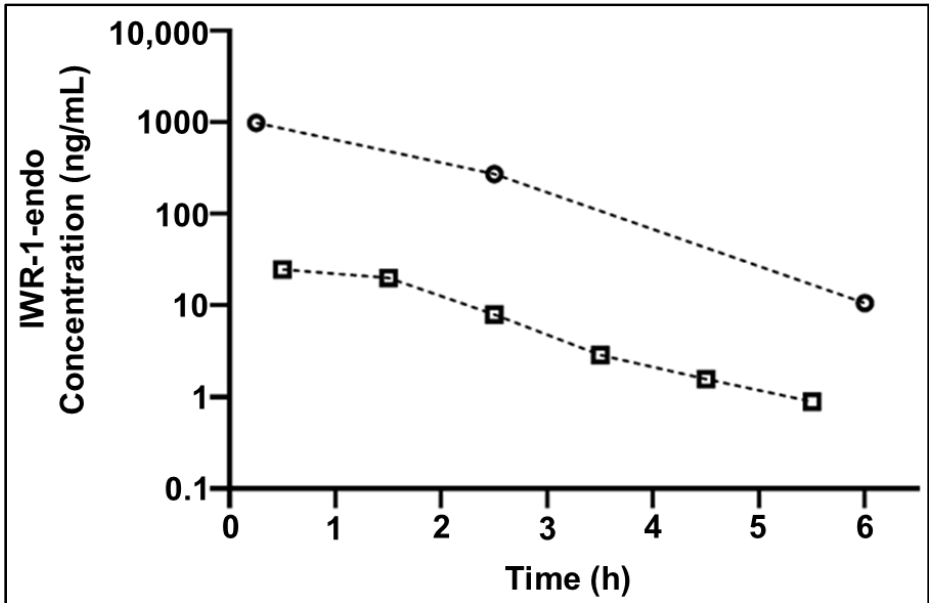
Figure 7. IWR-1-endo concentration–time profile in plasma and brain extracellular fluid (ECF) in a female non-tumor-bearing CD1 nude mouse. Open circles represent IWR-1-endo plasma concentra- tions, and open squares represent IWR-1-endo brain ECF concentrations .